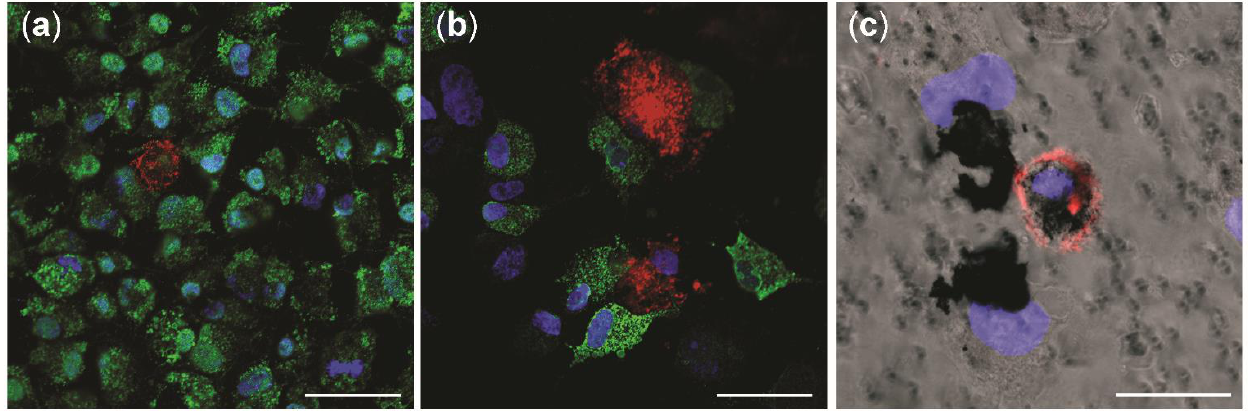
Figure 6. DNA strand breaks and oxidized DNA lesions, measured as DNA tail intensity, by the comet assay with Fpg in cells exposed at the air–liquid interface (ALI) to NM-300K. Cells were cultured as ( a ) monocultures, ( b , d ) cocultures, and ( c , e ) tricultures. Results are presented as mean of median ± SD of ( a ) n = 3–5, ( b – e ) n = 3 independent experiments. From each experiment, the median DNA tail intensity (%) was calculated from 50 cells per 2–6 gels from 1–2 cell culture inserts. Significantly different effects on DNA damage compared to PBS control were analyzed by ordinary one-way ANOVA followed by Dunnett’s post-hoc test (*** p < 0.001). SBs: strand breaks, NC: negative control, PBS: phosphate buffered saline, SD: standard deviation.